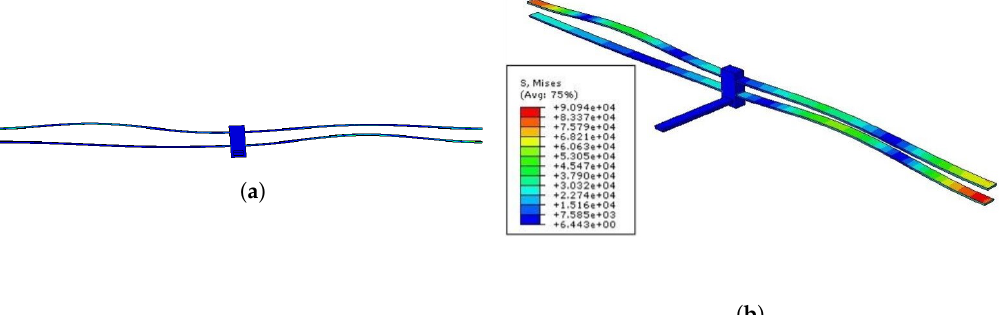
Figure 5. FEA of the device from the initial to the reversed stable configurations. ( a ) front view of the deformed shape during the transition; ( b ) contour plot of the Mises equivalent